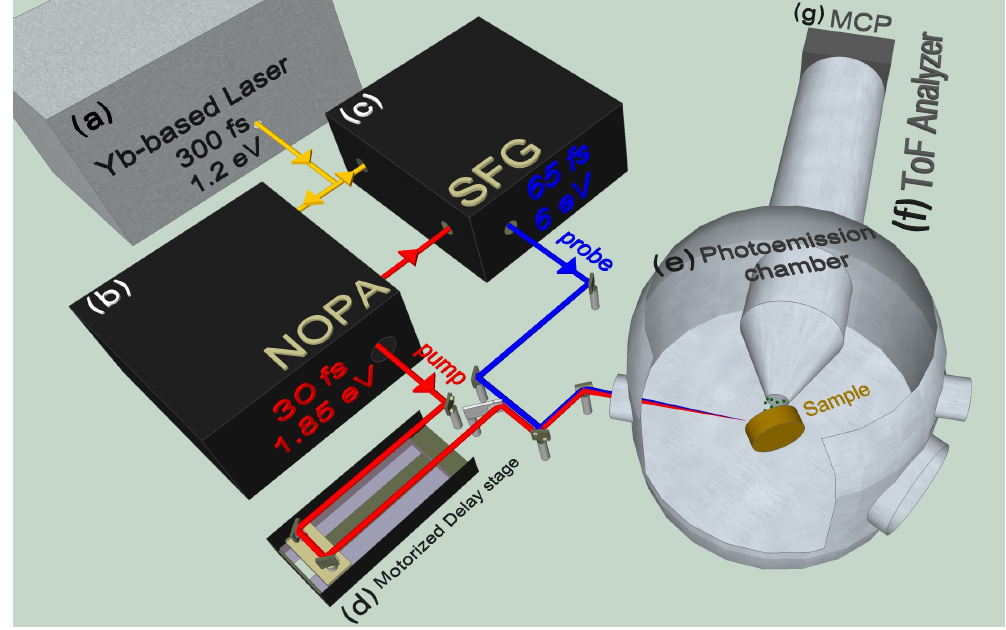
Figure 1. Schematic drawing of a time- and angle-resolved photoemission spectroscopy (TARPES) system: ( a ) Yb-based laser system generating 300 fs laser pulses with photon energy h ν = 1.2 eV ( λ = 1030 nm) at repetition rate of 100 kHz; ( b ) non-collinear optical parametric amplifier (NOPA) and ( c ) sum frequency generation (SFG) stage, which produce the pump (h ν = 1.85 eV, 30 fs)